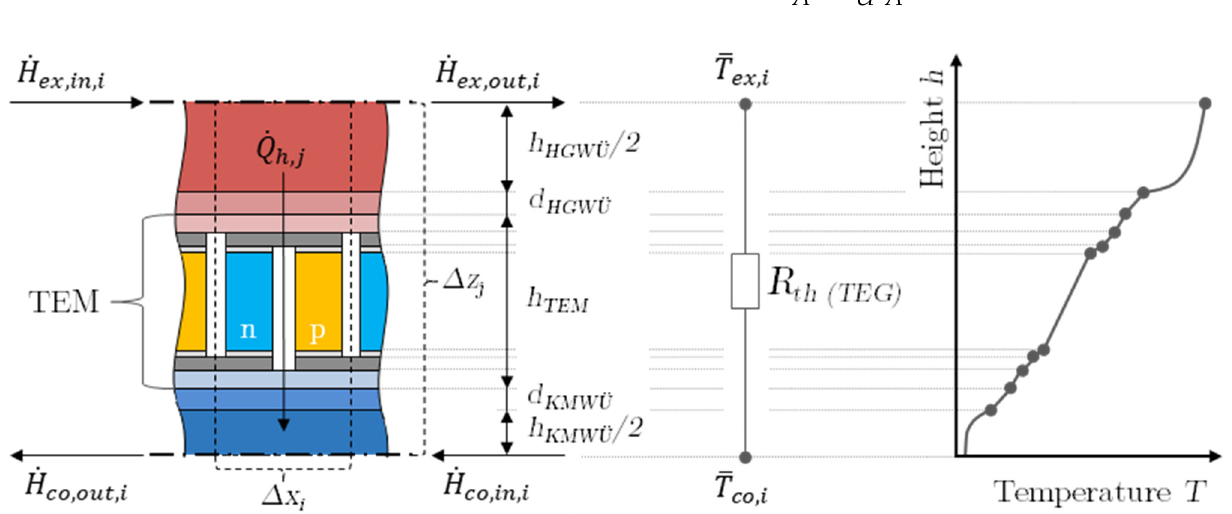
Figure 2. Thermodynamic design aspects of thermoelectric generators.